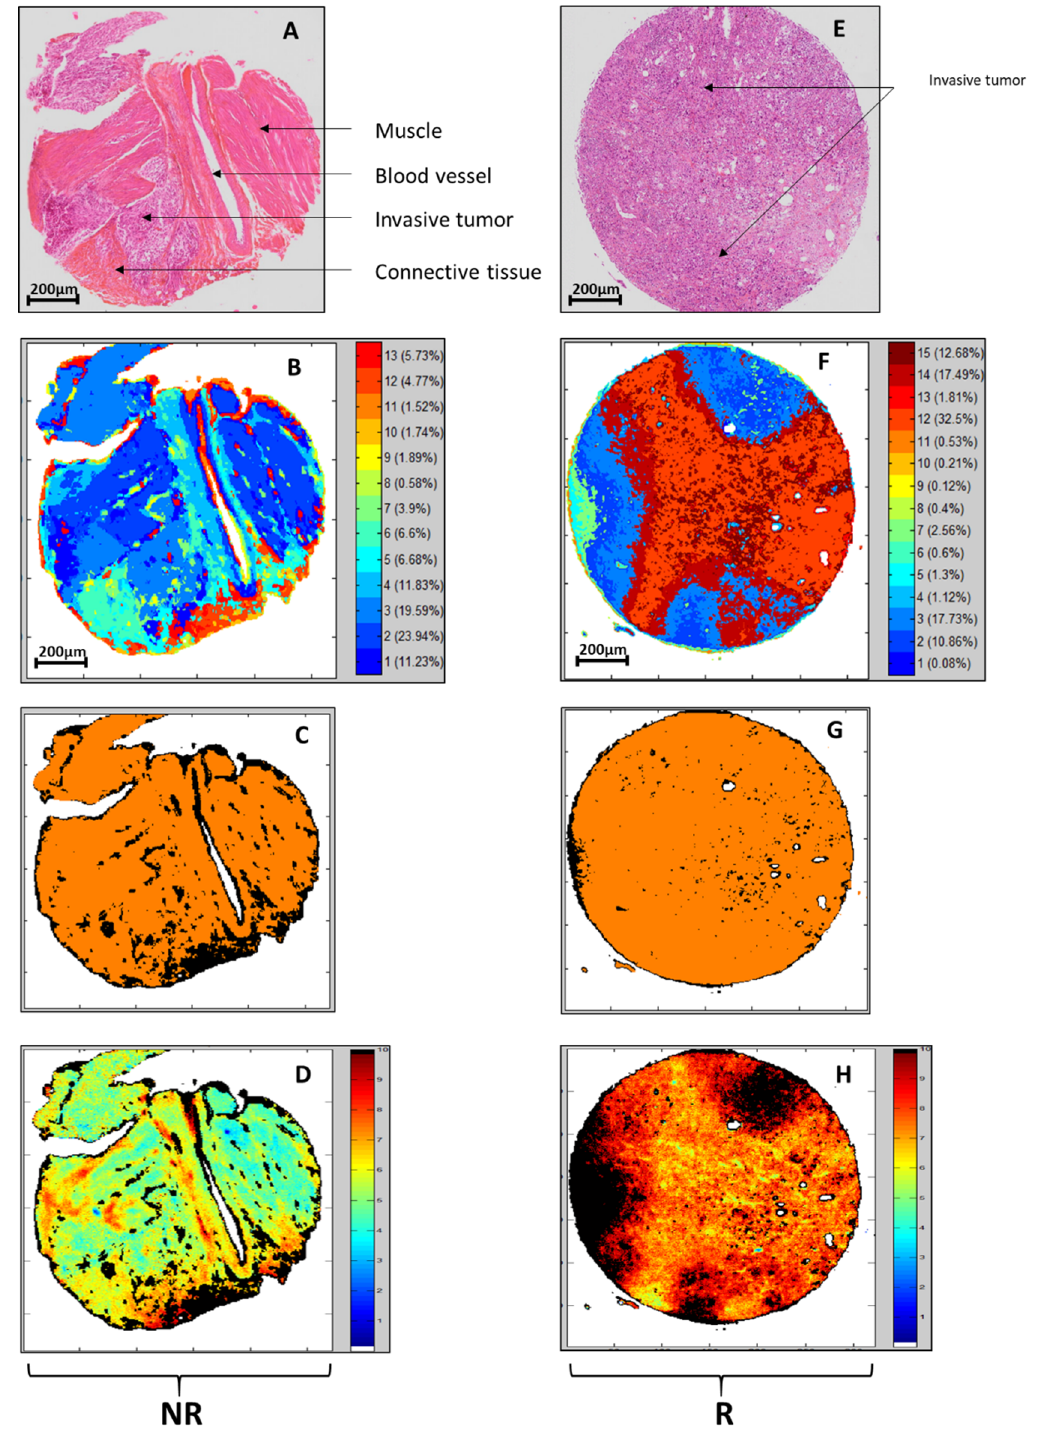
Figure 1. Histological images ( A , E ) and chemometric steps; including individual Kmeans clustering ( B , F ) for tissue structures recovering; PLS-DA ( C , G ) for automatic selection of pixels of interest and R/NR PLS scoring ( D , H ); for two representative calibration samples corresponding to NR and R patients. PLS was run with the infrared images of TMA spots allocated to calibration set as reference inputs; by considering a scale from 0 to 1 with scores of 1 (blue) and 9 (red) for NR and R respectively.